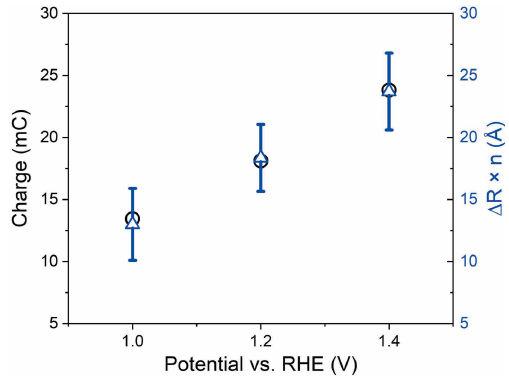
Figure 9 Comparison of the charge amount with the difference of Ir—O bond length for different modulation